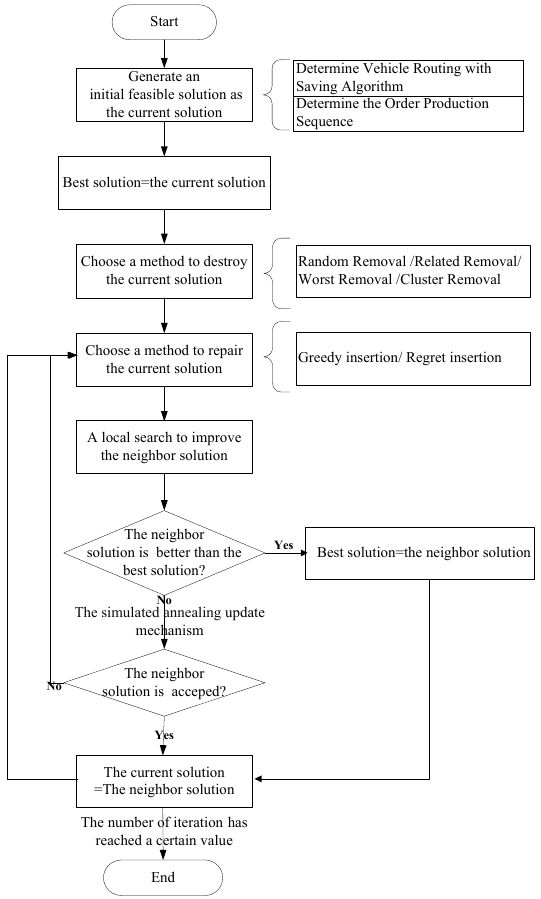
Figure 2. The major procedure of the improved large neighborhood search algorithm.